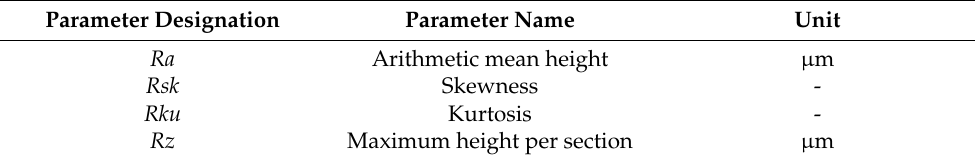
Table 1. Names and units of 2D roughness height parameters.